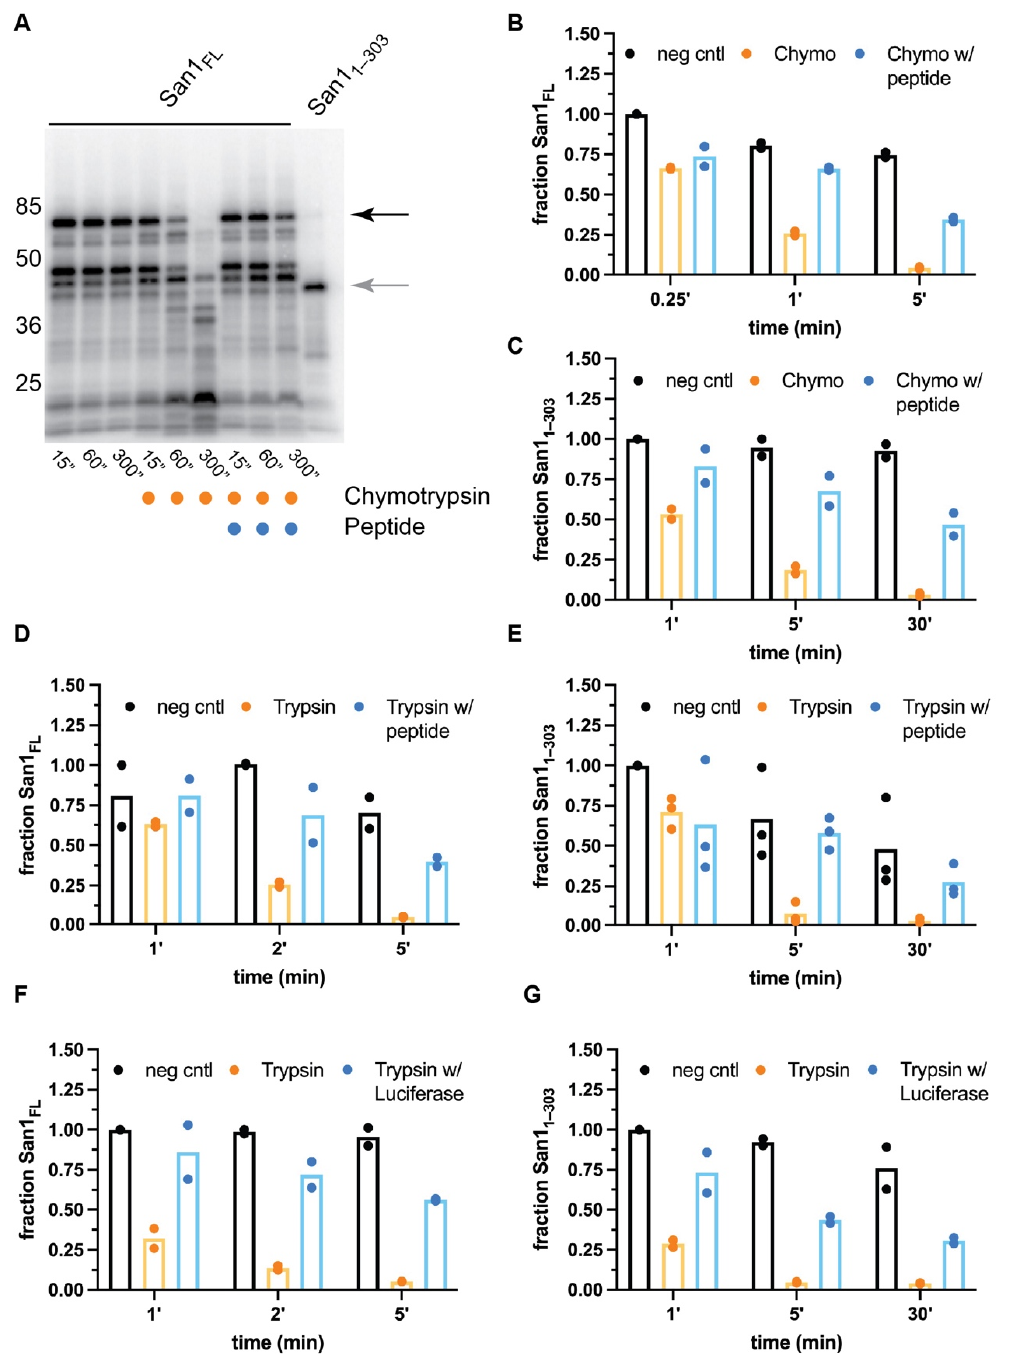
Figure 2. Peptide substrate significantly protects both full-length San1 and San1 1–303 from proteolysis. ( A ) Representative autoradiogram of a time-course for untreated, radiolabeled full-length San1 or San1 1–303 in the presence of chymotrypsin or in combination with peptide substrate. The migration of full-length San1 is noted by the black arrow on the right; San1 1–303 is shown in the rightmost lane (gray arrow). ( B ) Graph of the results in ( A ) where the fraction of full-length San1 remaining was normalized to the 15” time-point for the untreated sample (leftmost lane). ( C ) same as ( B ), except with San1 1–303 . ( D ) same as ( B ), except with the protease trypsin. ( E ) Same as ( C ), except with the protease trypsin. ( F ) same as ( D ), except with heat-denatured luciferase as substrate. ( G ) same as ( E ), except with heat-denatured luciferase substrate. Representative autoradiograms for the graphs shown in panels ( B ) through ( G ) can be found in Figure S1A–E, respectively. The results all show duplicate data points from technical experimental